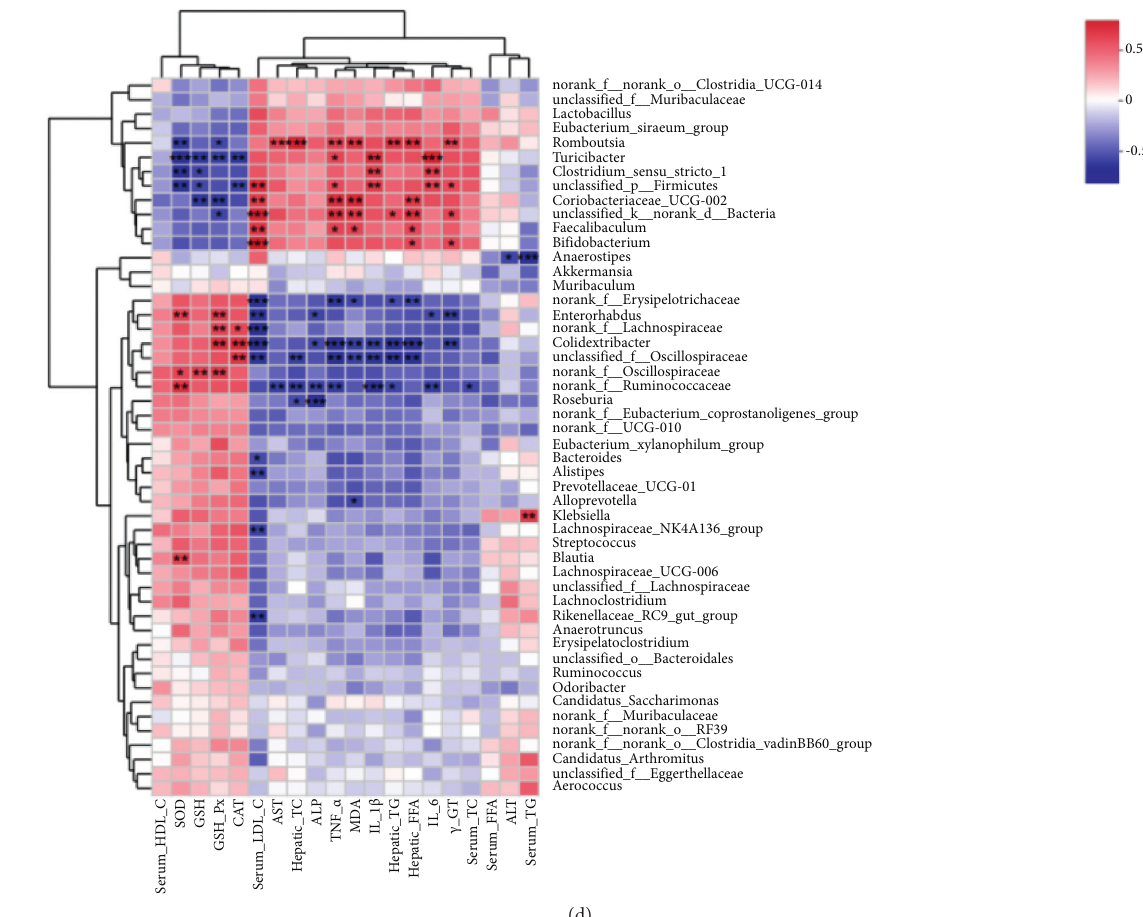
Figure 7: Effects of HPA on the changes of the colonic microbiota composition in ALD mice. (a) Venn diagrams of HPA; (b) percent of community abundance at phylum level; (c) percent of community abundance at genus level; (d) heatmap of spearman’s correlation analysis of the biological parameters and relative abundance of colonic microbiota at species level. ∗∗∗ p ≤ 0 . 001 and ∗∗ p ≤ 0 .